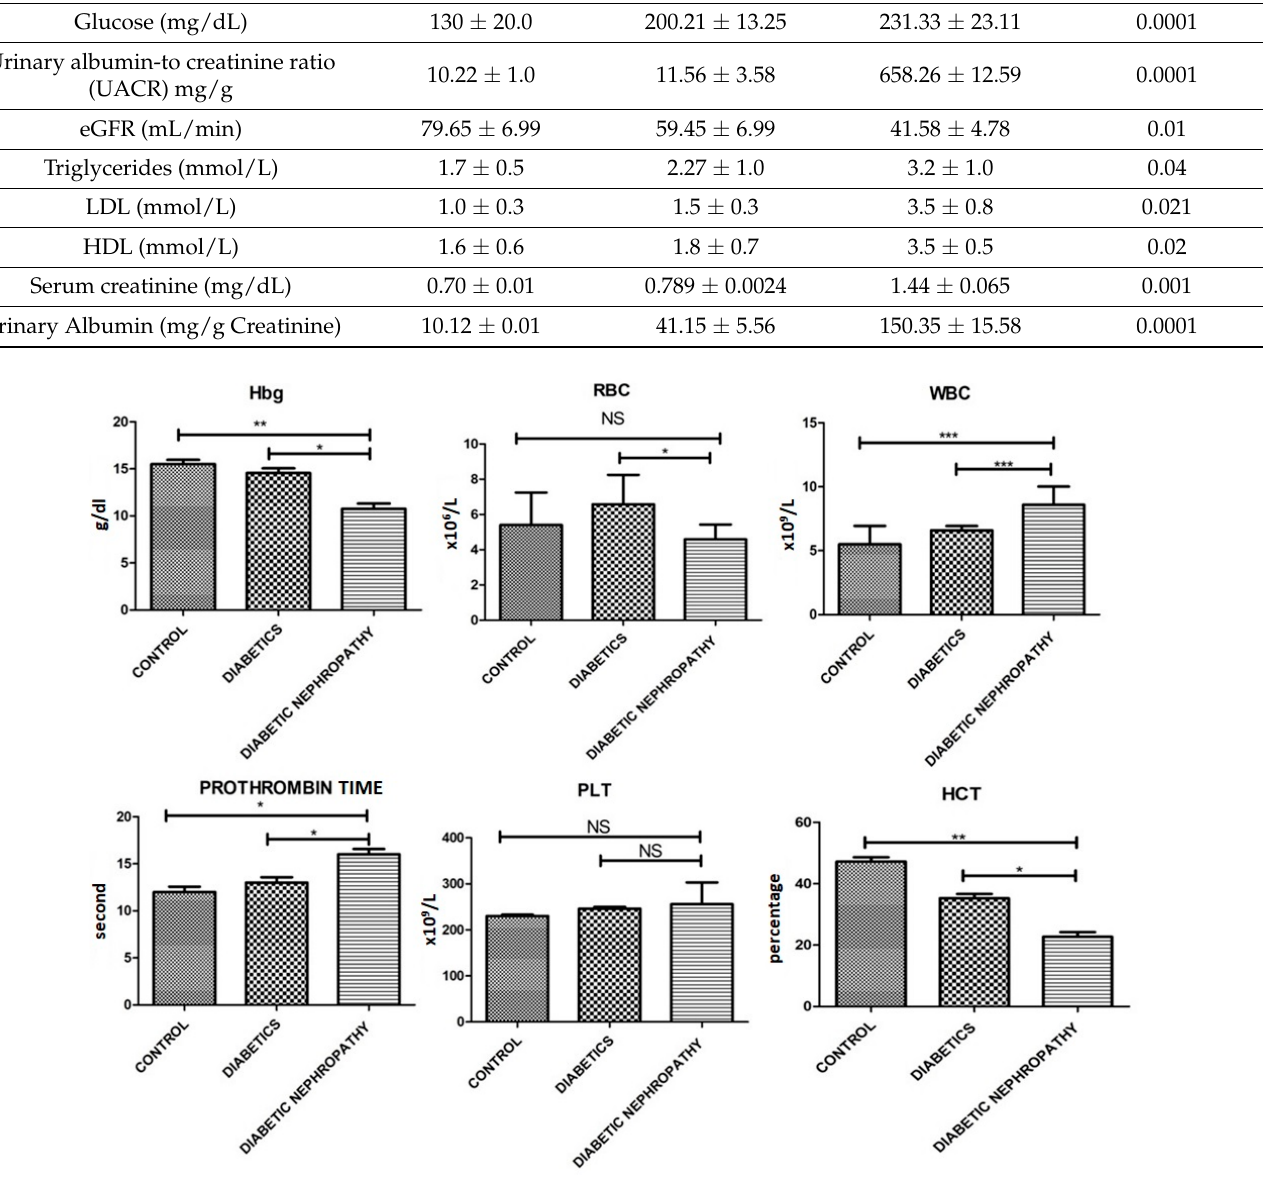
Figure 3. Hbg, RBCs, WBCs prothrombin, platelets, HCT. Of all the individuals there is a